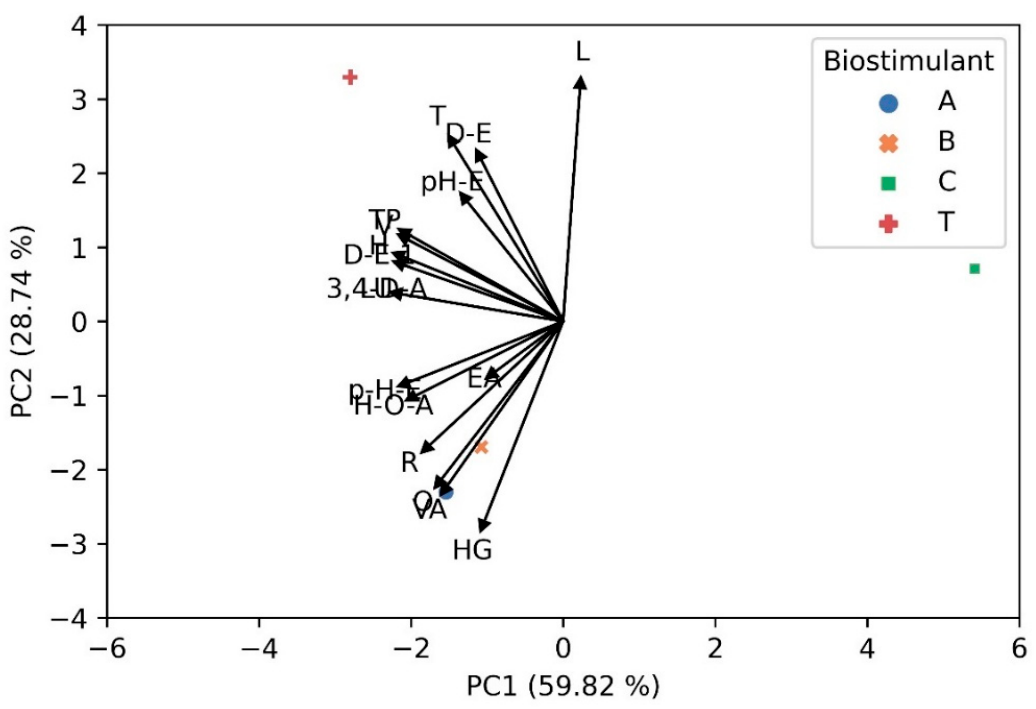
Figure 3. Principal component analysis (PCA) of drupe parameters: hydroxytyrosol glucoside (HG), hydroxytyrosol (3,4-DHPEA) (H), tyrosol (4-HPEA) (T), vanillic acid (VA), rutin (R), elenolic acid (EA), verbascoside (V), DHPEA-EDA (DE), ligstroside (L), oleuropeina (O), p HPEA-EDA (pH-E), hydroxy-oleuropein-aglycon (H-O-A), luteolin (LU), 3,4-DHPEA-AC (3,4-D-A), DHPEA-EA (D-E), p-HPEA-EA (p-H-E), and total polyphenols (TP). C = control, T = trichoderma, B = glycine betaine, A = tropical plants extract.